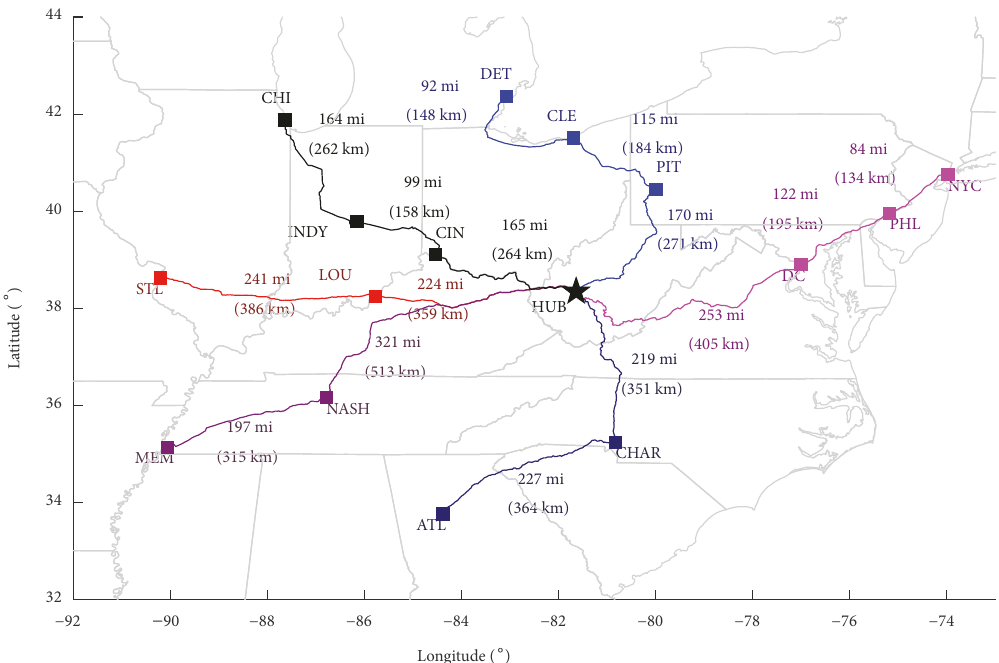
Figure 1: Solution of mass transit system (total distance = 2692.9 mi (4333.8 km); iteration = 770).